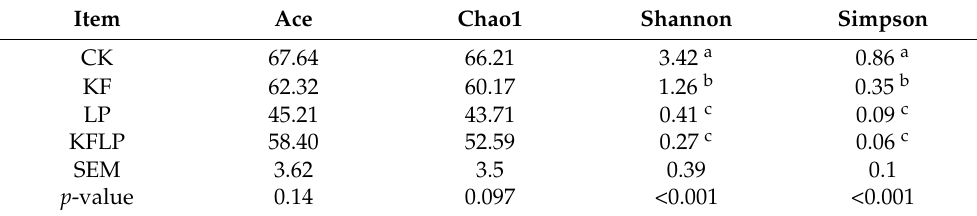
Table 4. Alpha diversity of bacteria in forage rape silages fermented with KF and LP for 60